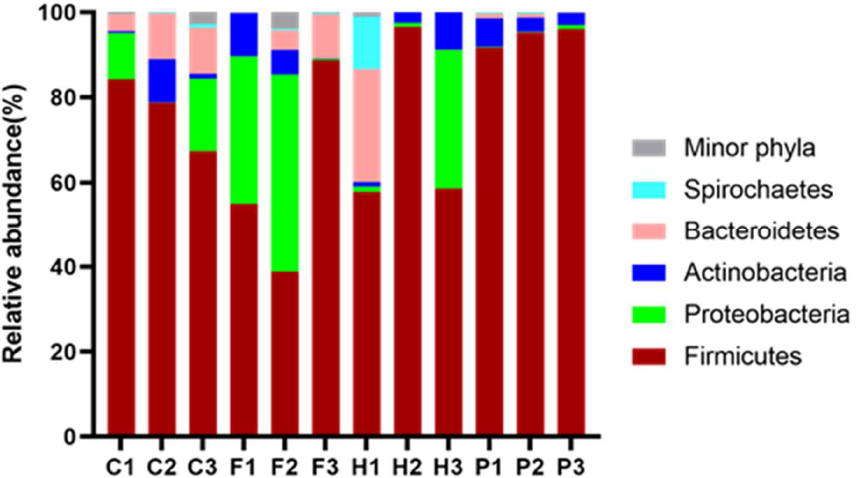
Figure 1. Relative Abundance of Sequences Representing Phyla Constituting Bacterial Communities in Different Animal Manure Samples.